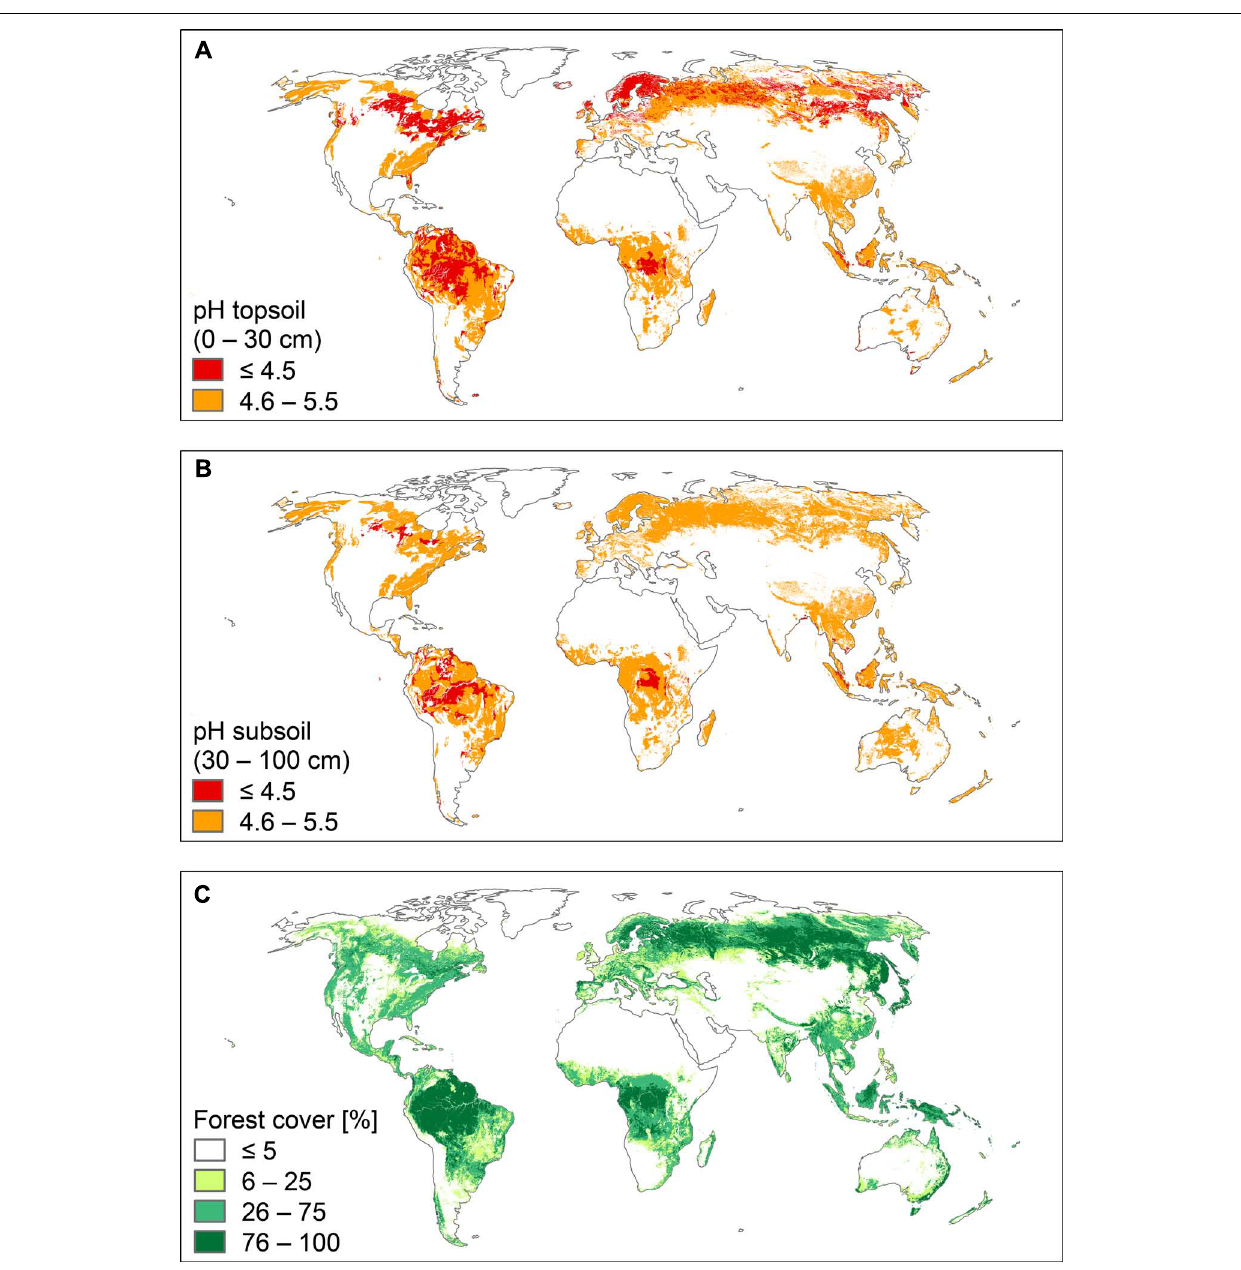
FIGURE 1 |World acid soils and world forests. (A) pH of topsoil (0–30 cm), (B) pH of subsoil (30–100 cm), and (C) forest cover. Soil pH is presented in two classes: pH ≤ 4.5 (strongly acid soils) and pH 4.6–5.5 (moderately acid soils). Data were retrieved from the HarmonizedWorld Soil Data Base